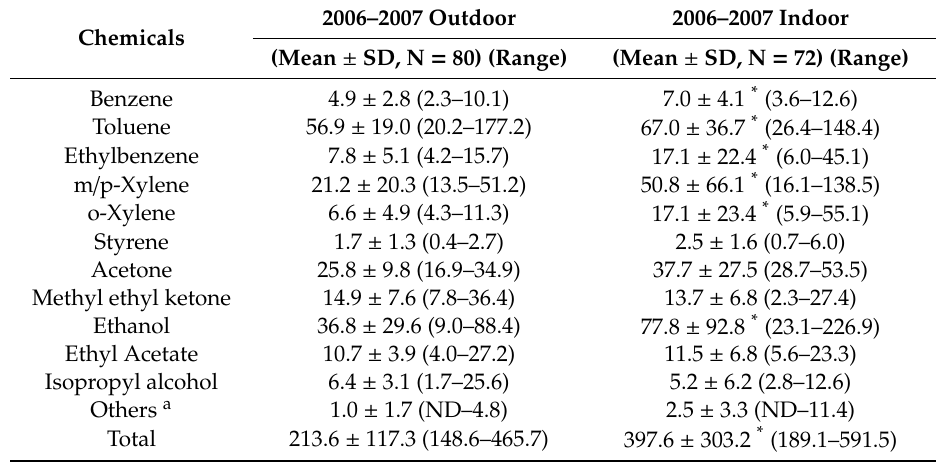
Table 1. Average concentrations ( µ g / m 3 ) of indoor and outdoor volatile organic compounds (VOCs) over two